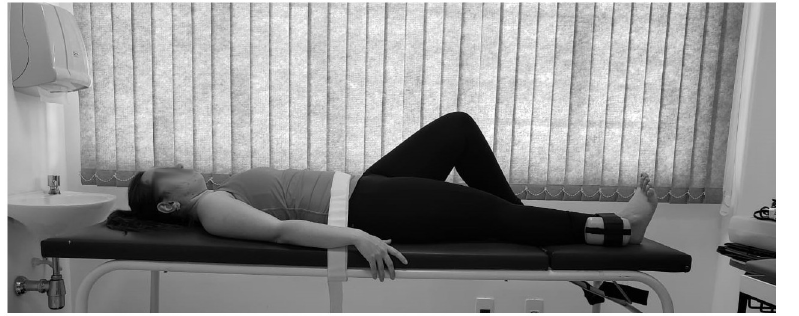
Fig 3. Hip abductor muscles evaluation.